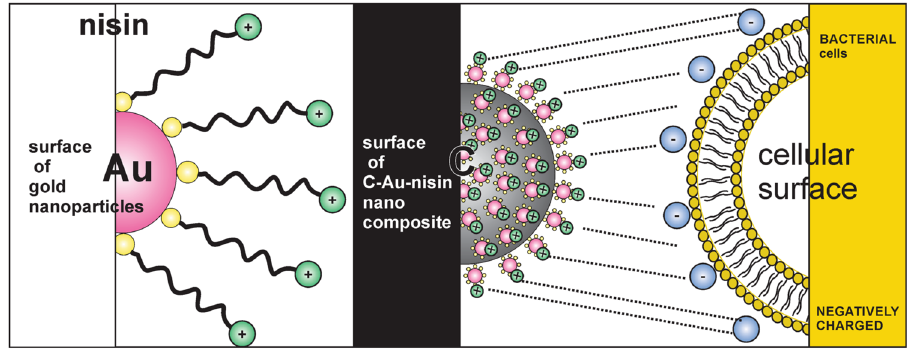
Figure 1. Illustration of the developed nano-engineering approach. Functionalization of the nisin at gold nano-features and uniform arrangement of gold nano-features on carbon-submicrospherical templates with an intensive positive charge available for an interaction with bacterial